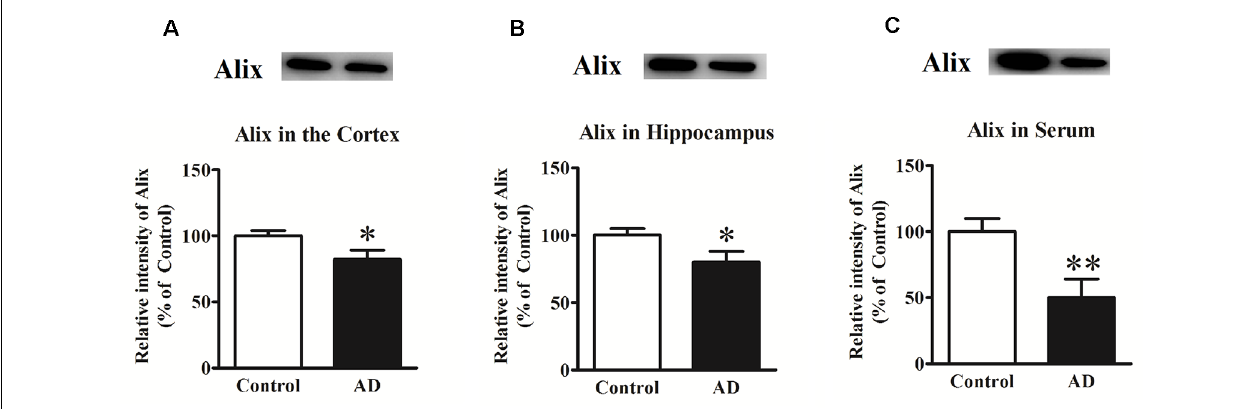
FIGURE 1 | (A) Western blot analysis of Alix in the cortex tissues from Alzheimer’s disease (AD) patients and controls. (B) Western blot analysis of Alix in the hippocampus tissues from AD patients and controls. (C) Western blot analysis of Alix in serum samples from AD patients and controls. Quantified results were normalized to β -actin/IgG expression. Values were expressed as percentages compared to the controls (set to 100%) and represented as means ± SEM. n = 12 per group. ∗ p < 0.05, ∗∗ p < 0.01 vs. the control group, Student’s t -test.